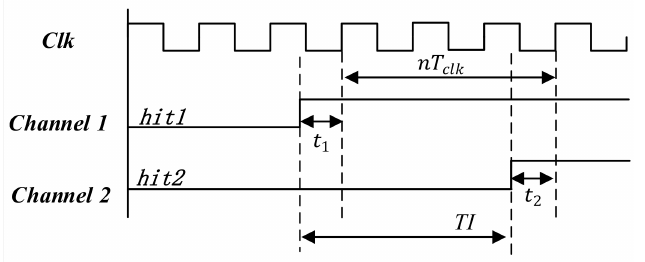
Figure 2. Timing diagram of time interval measurement. nT clk is the coarse time. t 1 and t 2 are the fine times, and TI is the time interval between hit1 and hit2